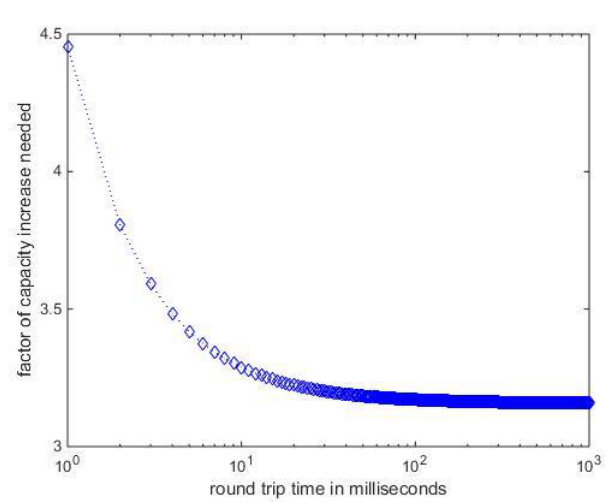
Figure 4. Capacity increase factor for C = 20Mbps and